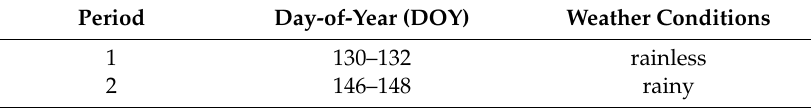
Table 1. Selected periods with their weather